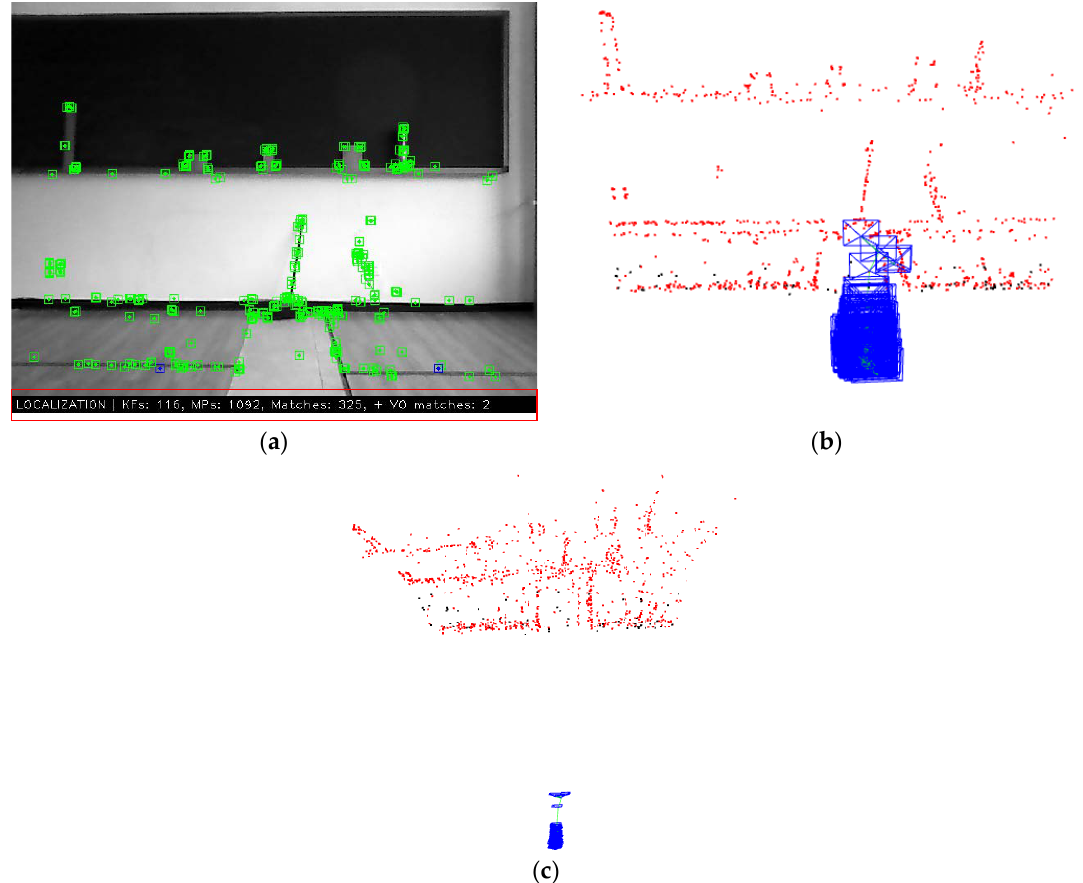
Figure 11. The original mapping effect. ( a ) Current RGB image frame after map data has been Figure 10. The original mapping effect. (a) Current RGB image frame after map data has been stabilized; ( b ) sparse point-cloud map with the same angle-of-view as the camera; ( c ) vertical-view stabilized; (b) sparse point-cloud map with the same angle-of-view as the camera; (c) vertical-view angle of the angle of the map.